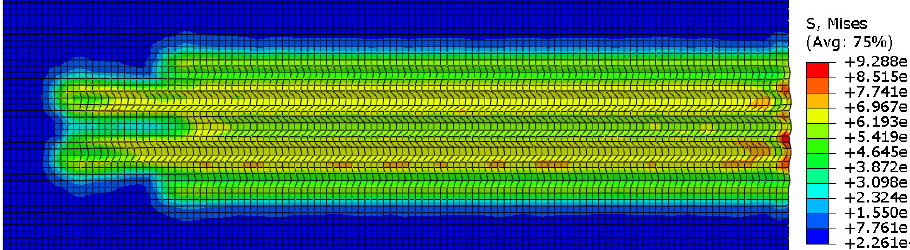
Figure 6. The whole-tooth furrow stress.